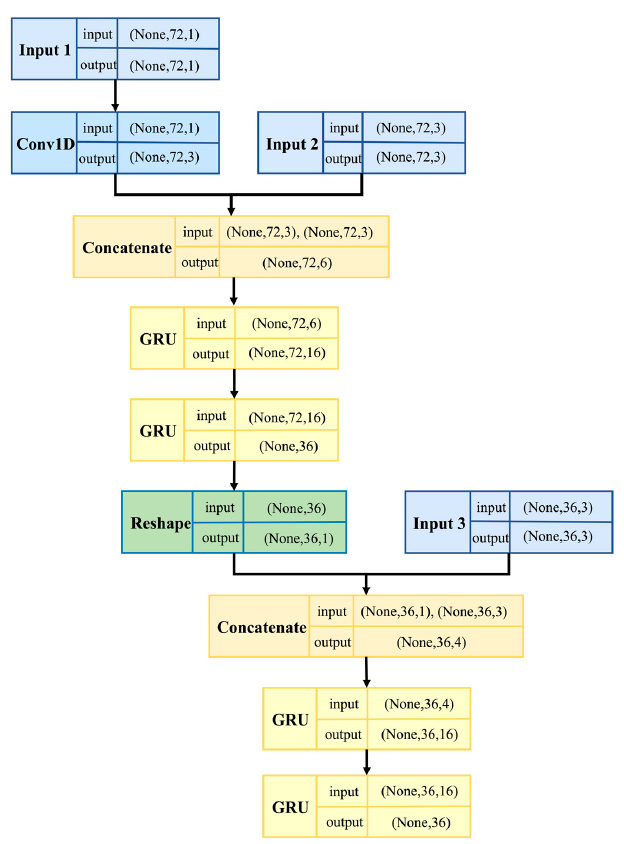
Figure 6. The structure of the Con-GRU model.